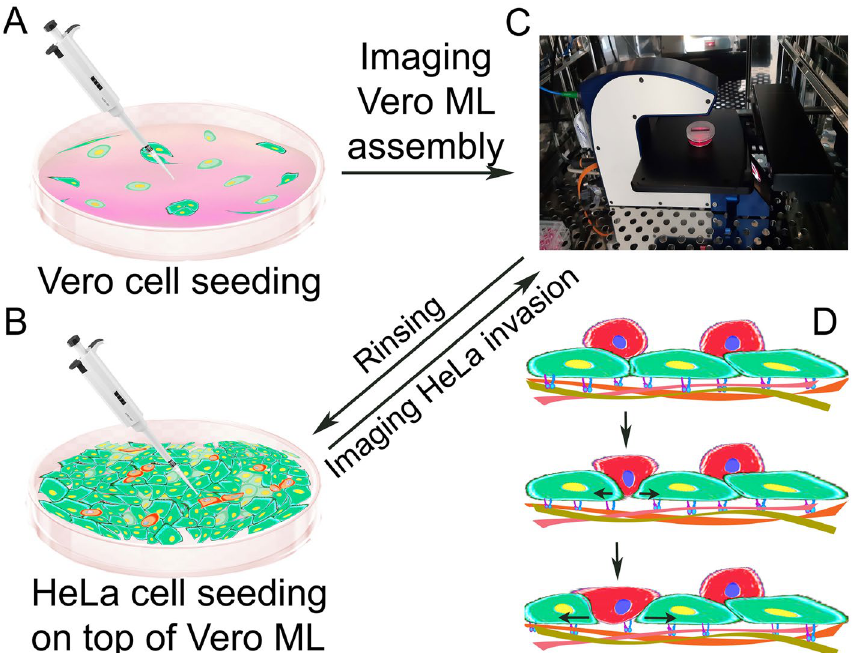
Figure 1. Schematics of experimental design, execution, and results. ( A ) Seeding of Vero cells (green) on gelatin-coated dish. ( B ) Seeding of HeLa cells (red) on top of the self-assembled 100% confluent Vero monolayer (ML). ( C ) Holomonitor M4 was used to image monolayer assembly and invasion for 24 h. ( D ) Illustration of the expected result, the HeLa cells seeded on top of the Vero monolayer infiltrate by searching for optimal invasion